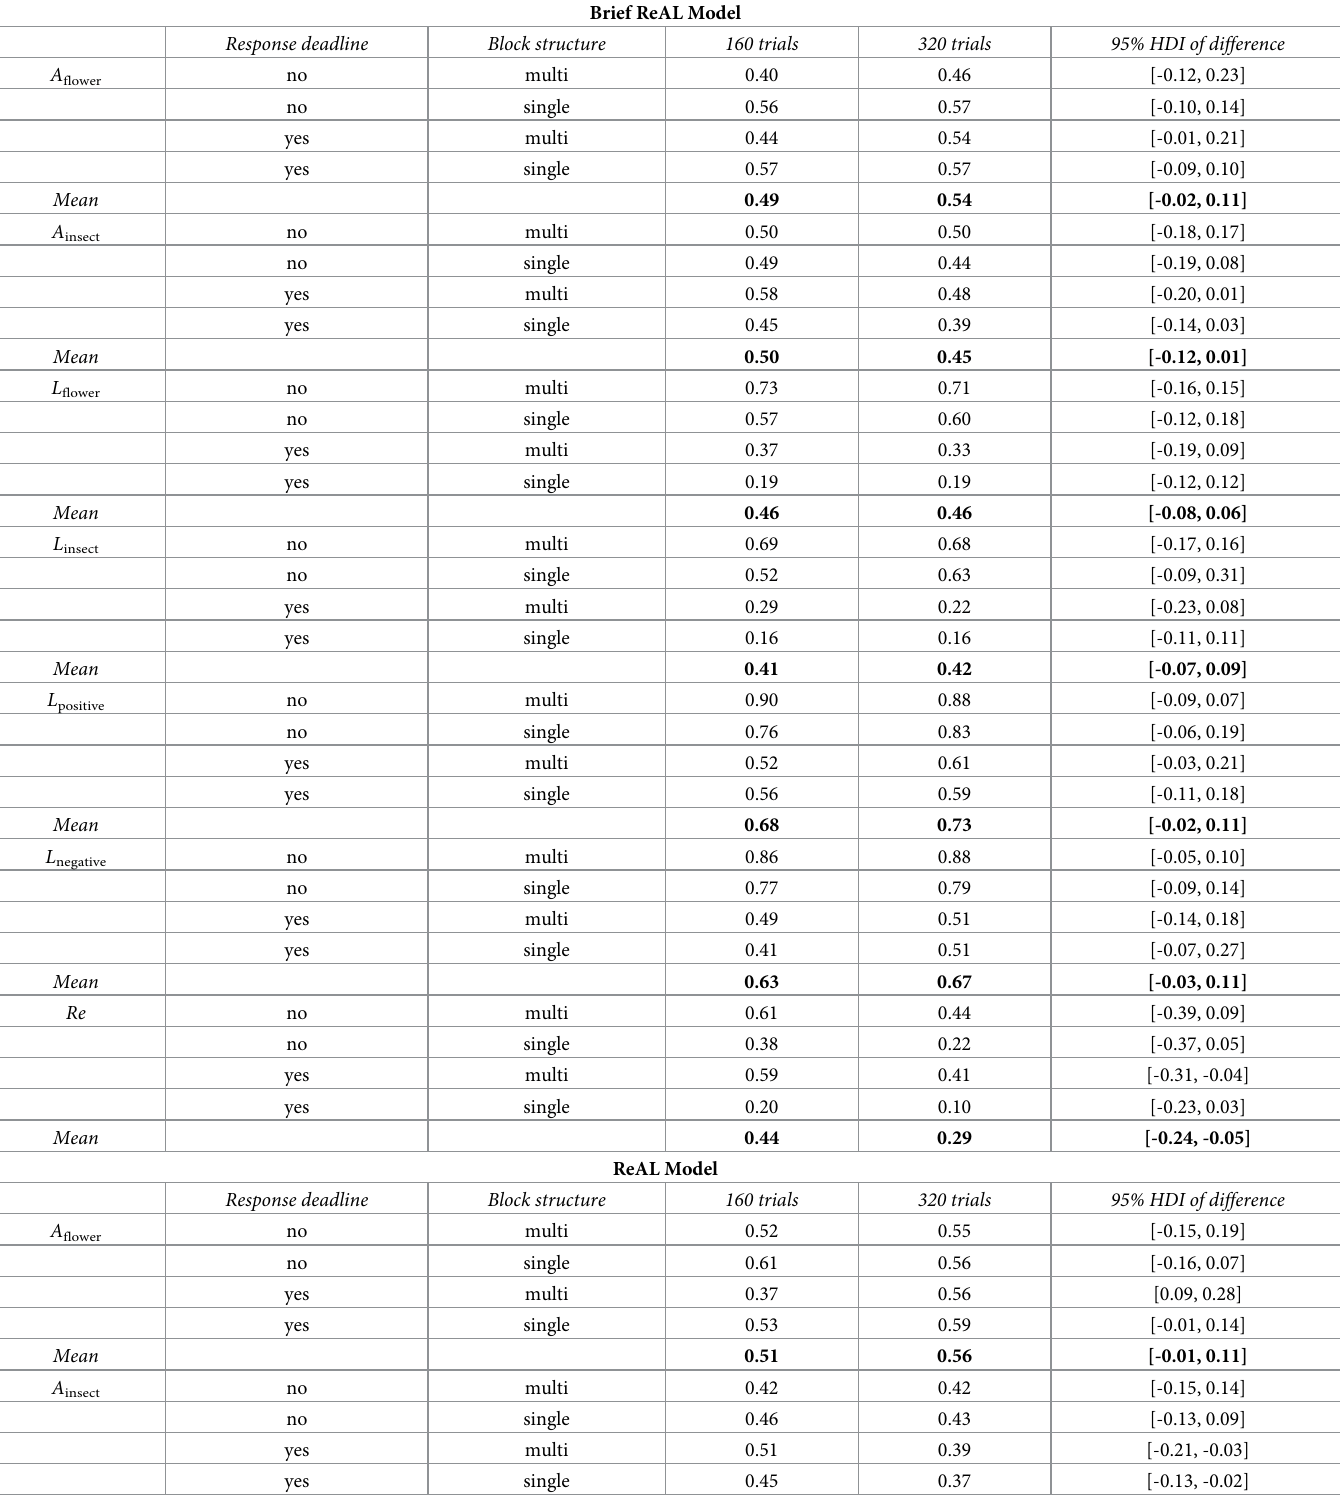
Table 7. Mean parameter estimates from 160-trial versus 320-trial